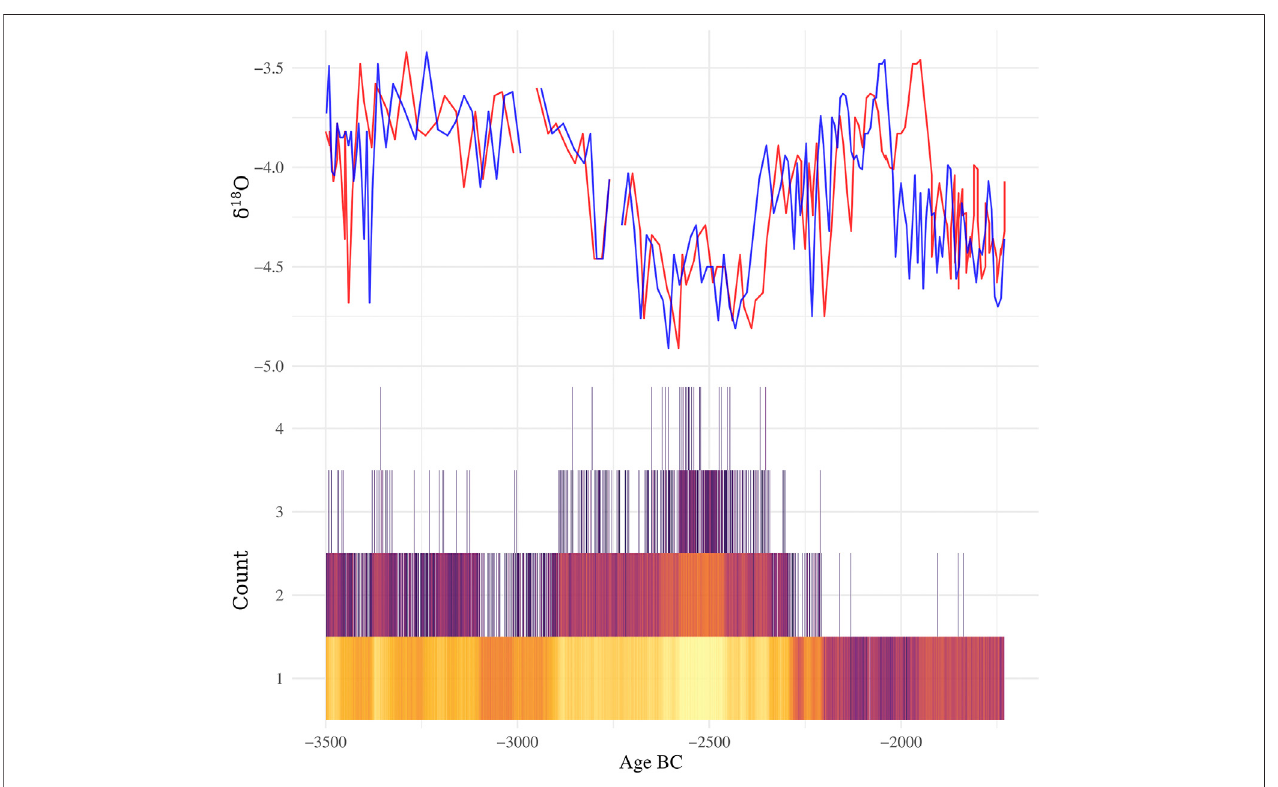
FIGURE 9 | The δ 18 O record from Renella Cave, with blue line showing published age-depth model (Zanchetta et al., 2016 and red line our age-depth model from OxCal. More negative values indicate more rainfall, and less negative values indicate more arid conditions. Radiocarbon dated event count (REC) ensembles at bottom summarises multiple sequences of events which are compatible with the data, i.e., years in which archaeological activity is present. Brighter colours and higher y -axis values indicate a greater chance of archaeological activity at that time. See Carleton (2020) and Stewart et al. (2020) for more information on the REC model